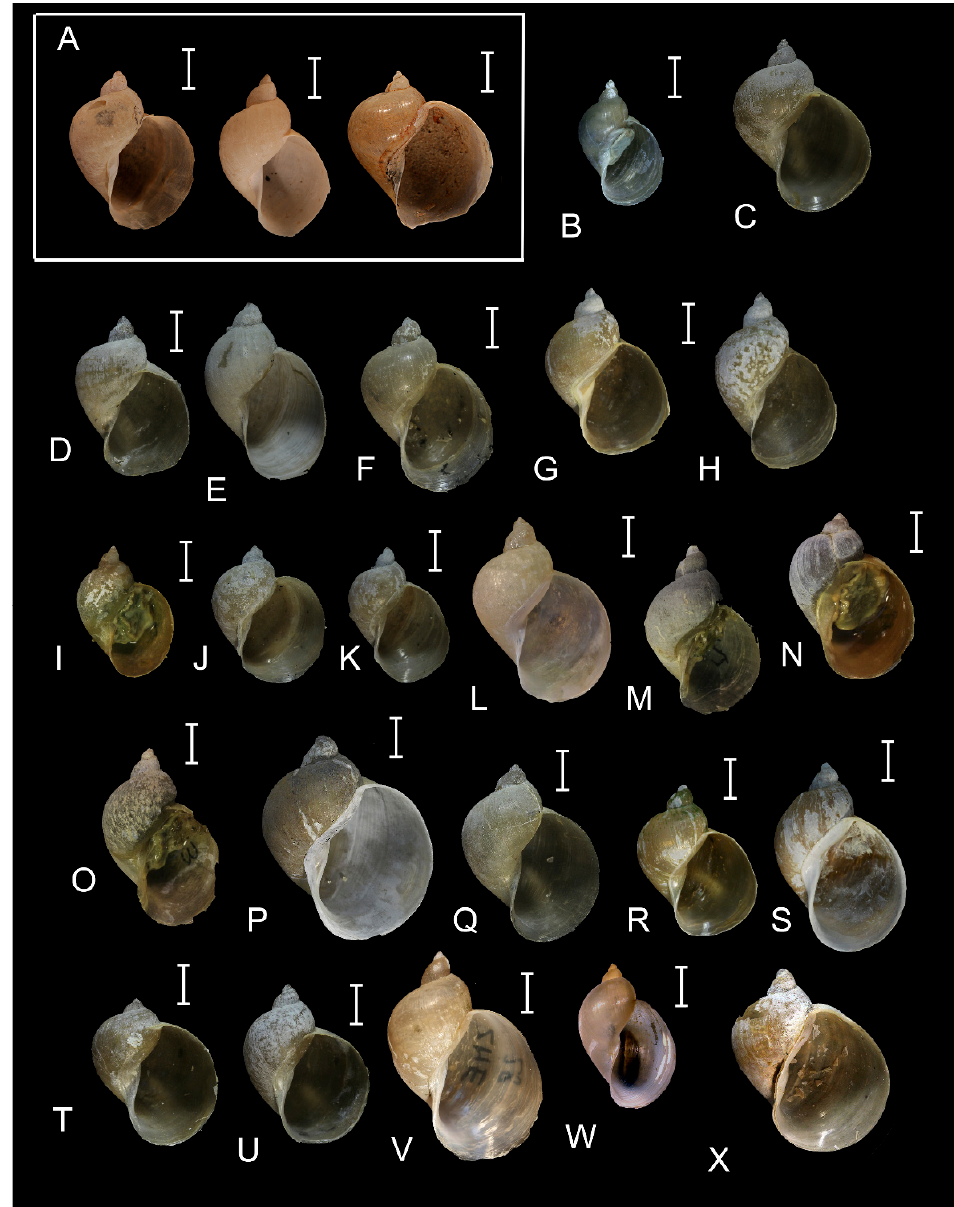
Figure 6. ( A ) The lectotype (left shell) and two paralectotypes of Limnaea auricularia var. intercisa Lindholm (ZIN). ( B ) Bol’shie Koty (SW), groundwater ‘puddle’, 3–5 m from shoreline. ( C ) Elokhin Cape (NW Baikal), depth 4–10 m. ( D , E ) Bol’shie Koty, near Zhilische, depth 2.5–4.2 m. ( F ) Listven- ichnoye, 1–9 m depth. ( G , H ) Peshanaya Bay. ( I ) Cape Zub (Khabartuy), depth 3–10 m. ( J , K ) North of Buguldeyka, 2–3 m depth. ( L ) Maloye More, Kharin–Irgin Bay, 1.2 m depth. ( M ) Shibeteyskaya Bay. ( N ) Valukan Cape, 0.1–0.15 m depth. ( O ) Bolshaya Kosa Bay, depth 30 m. ( P ) Senogda Bay, depth 0.5 m. ( Q ) Slyudyanskiy Cape (NW), depth 2.8–3.2 m. ( R , S ) Baikal near Zarechnoe, 0.5 m depth. ( T , U ) Ayaya Bay (NE), depth 0.5 m. ( V – X ) Chivyrkuy Bay, Zmeinaya Bight, 0.5 m depth. Scale bars = 5 mm.